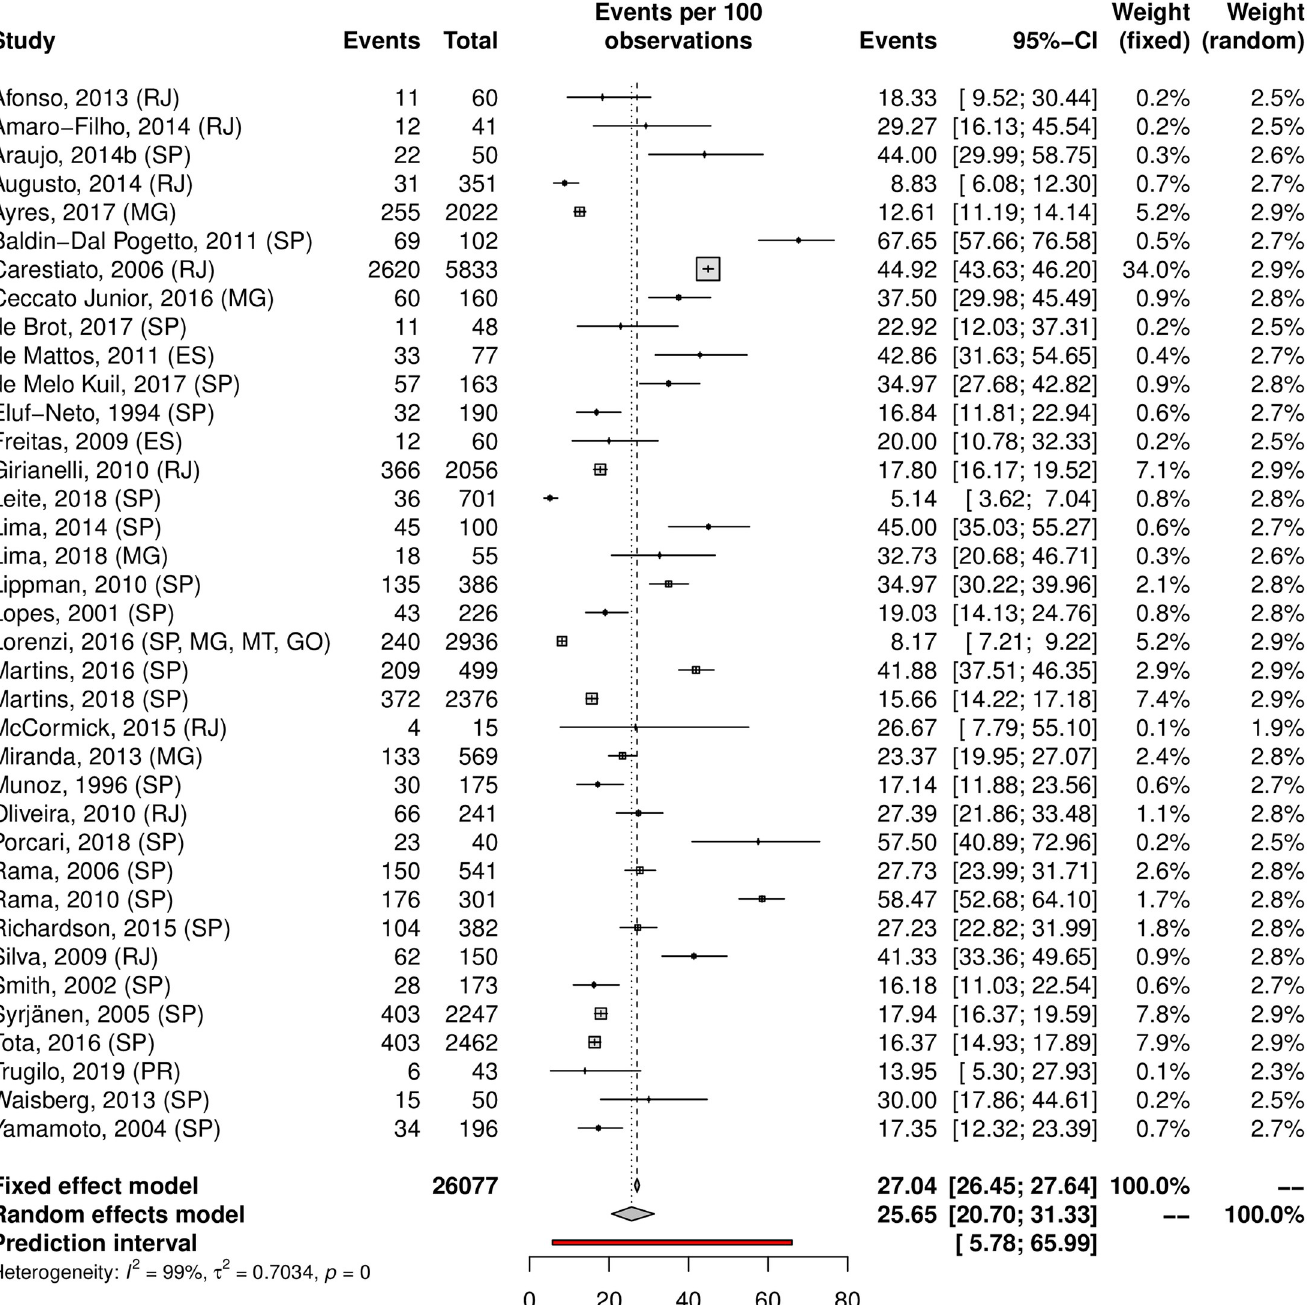
PLOS ONE | https://doi.org/10.1371/journal.pone.0229154 February 21,